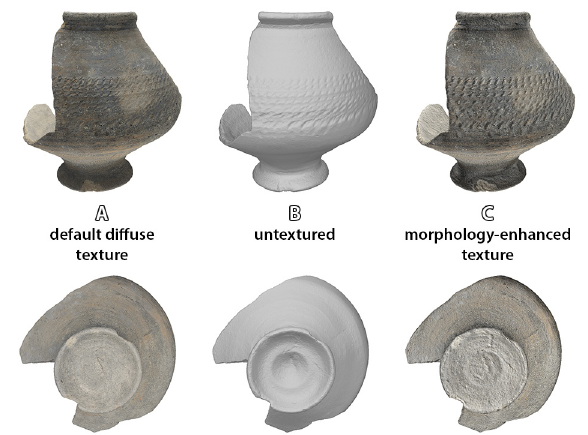
Figure 1. A triangular mesh with (A) and without (B) its default diffuse texture. The new texture (C) conveys the pot’s colour along its morphological features in a quasi-photorealistic